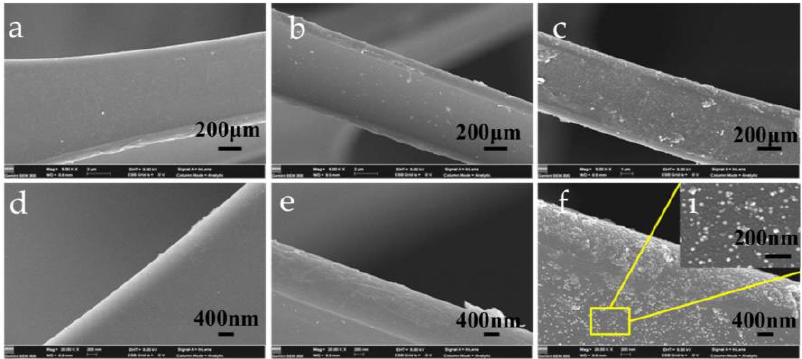
Figure 3. The scanning electron microscopy (SEM) image of the MS ( a , d ), the MS–TA ( b , e ), and the